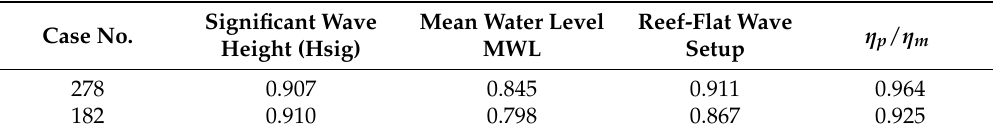
Table 2. Model skills and ratio of maximum wave setup of Case 278 and 182.